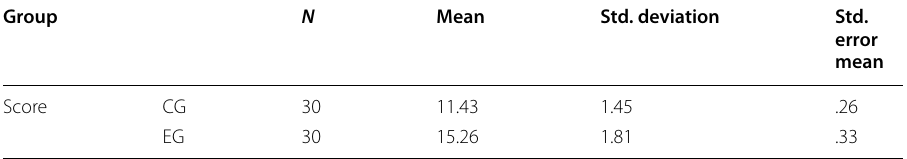
Table 13 Complexity post‑test descriptive statistics Group